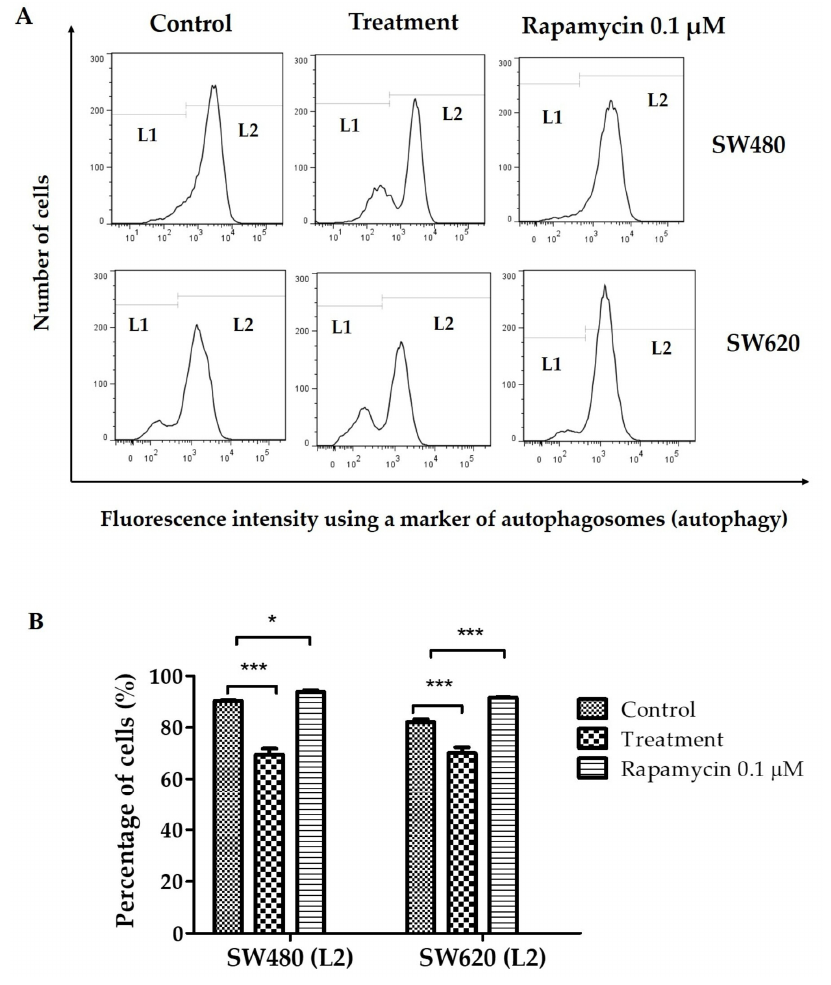
Figure 8. Effect of LMPE on autophagosome production (autophagy) in SW480 and SW620 cell lines. Cells were exposed to 30 mg LMPE/mL for 48 h. Untreated cells (0 mg LMPE/mL) were used as a control. 0.1 µ M rapamycin was used as a positive control. Histograms represent the fluorescence intensity of an autophagosome marker (detected by flow cytometry) ( A ). The cells with low autophagosome production are located at L1 and the cells with high autophagosome production are at L2. Percentage of cells located at L2 ( B ). Data are expressed as mean ± SEM ( n = 3). The ANOVA test was performed to compare the groups of cells located at L2, p < 0.0001 in both cell lines. The differences between the means of the groups and the control group were analyzed by Dunnett’s post-hoc test. The significant differences were expressed as * p <0.05 and *** p <0.001.